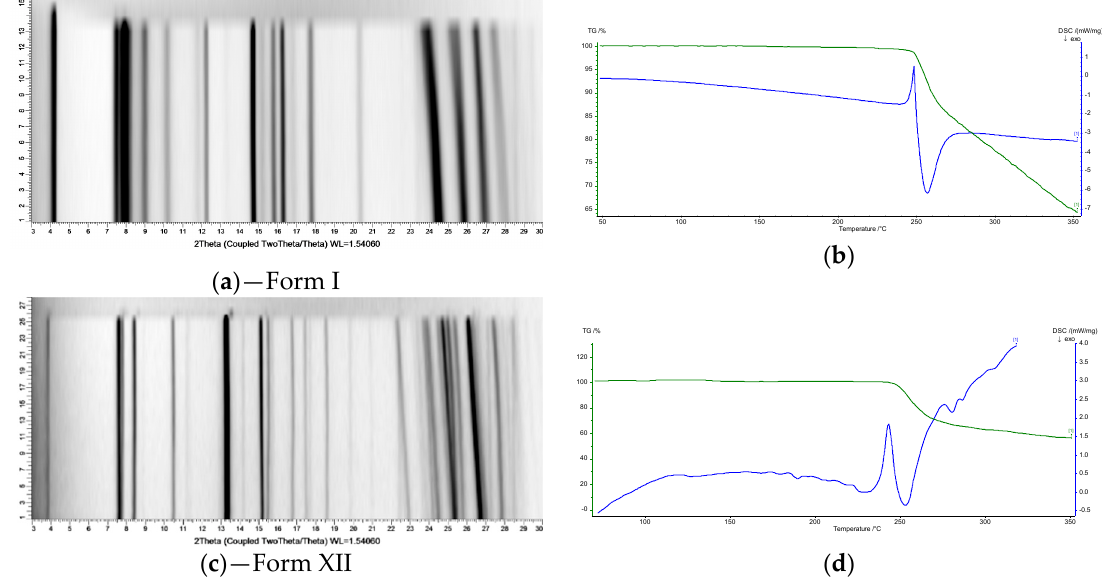
Figure 2. Variable Temperature X-ray Diffraction (VTXRD) traces of Form I ( a ) and Form XII ( c ). Horizontal scale: 2 θ (°); vertical scale: progressive number of VTXRD measurements in isothermal conditions (in 20 °C steps each, in the 30–270 °C range). In panels ( b ) and ( d ), the pertinent TG (in green) and DSC (in blue) traces show that the unique thermally induced event, in both Form I and Form XII, is the incipient melting/decomposition occurring near 250 °C.